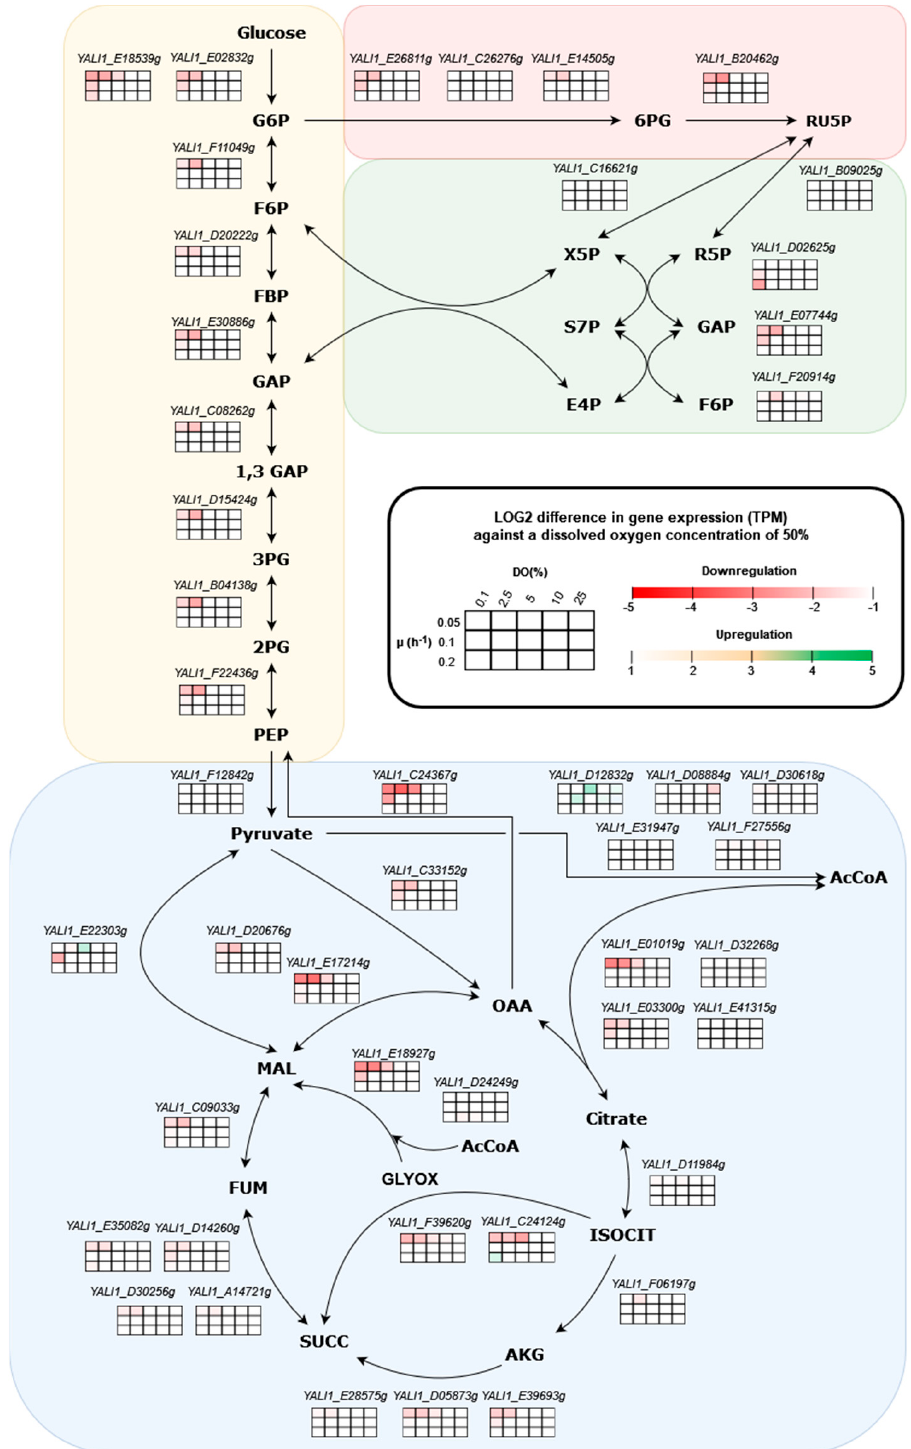
Figure 6. Differential expression of genes involved in the central carbon metabolism of Y. lipolytica . The 5 × 3 table indicates 15 experimental conditions. Horizontally, 5 different dissolved oxygen (DO) percentages and vertically, 3 growth rates are shown. The coloring of the table is based on the log2 difference in gene expression as TPM values compared to a DO value of 50% at each respective growth rate. The red color scheme indicates gene downregulation and the green values indicate upregulation. White cells indicate a log2 di ff erence between − 1 and 1 and are considered not significant.